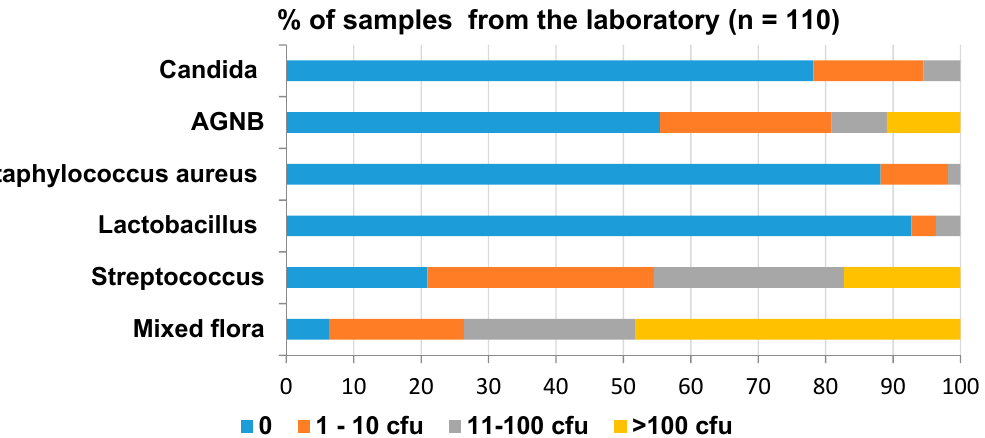
Figure 4. Overall level of contamination in the dental laboratory.